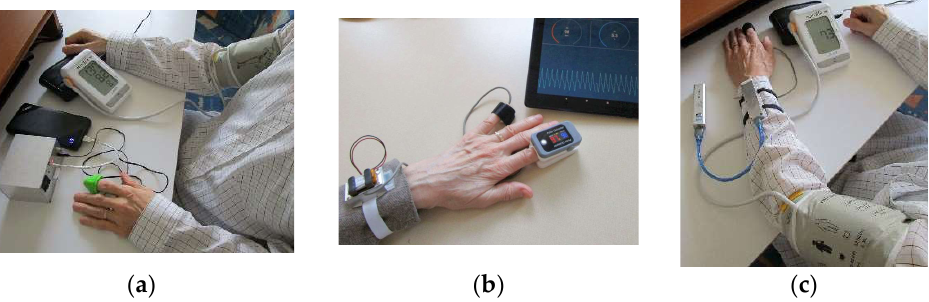
Figure 9. Arrangements of comparative measurements of HR values from the PPG wave and by the BPM and POXI devices: ( a ) with parallel measurement by the BPM device on the right hand and the PPG-EP sensor on a forefinger of the left hand; ( b ) parallel sensing of the PPG signal via the POXI with BT data transfer to a tablet and by the PPG-BLE sensor using a forefinger and a pinkie of the left hand; ( c ) parallel measurement by the BPM device and by the PPG-PS1 sensor worn on a forefinger-both placed on the left hand.